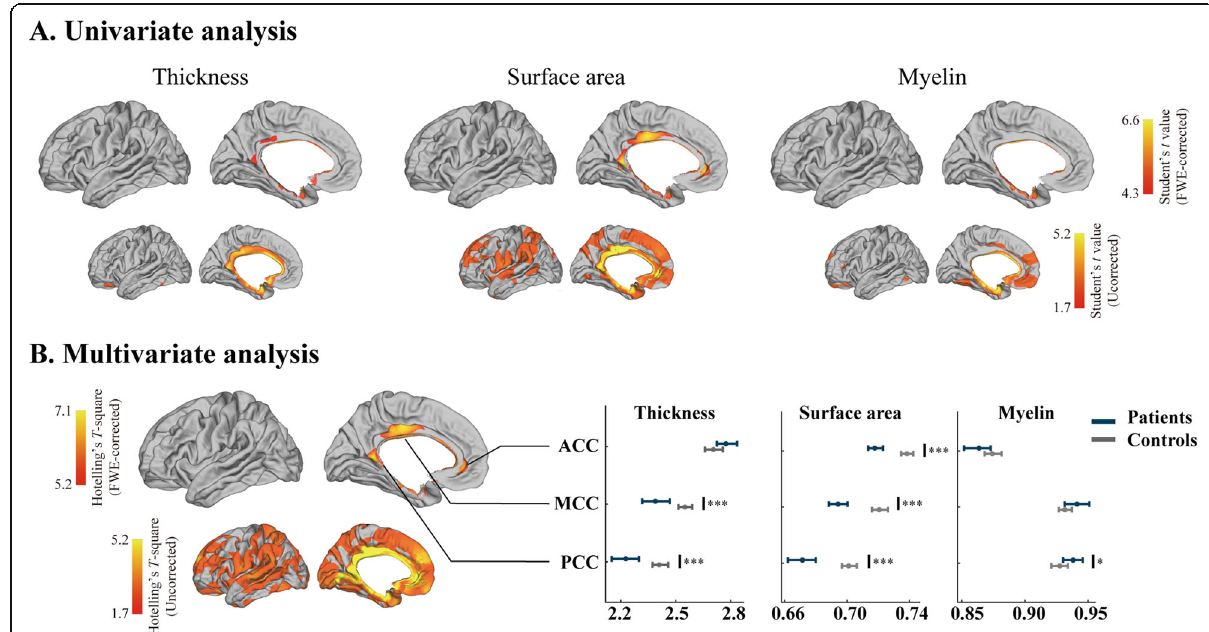
Fig. 1 Neocortical surfaced-based feature analysis. A Univariate analysis identified clusters that differed significantly relative to controls. B Multivariate analysis of the joint distribution of thickness, surface area, and myelin. Comparisons between TN patients and controls with respect to the different neocortical features for different significant clusters. The t values are denoted by colored bars, with random field theory having been used to correct significant clusters for multiple comparisons at a P FWE < 0.05. Abbreviations: ACC: anterior cingulate cortex; MCC: midcingulate cortex; PCC: posterior cingulate cortex; *: P < 0.05; ***: P <